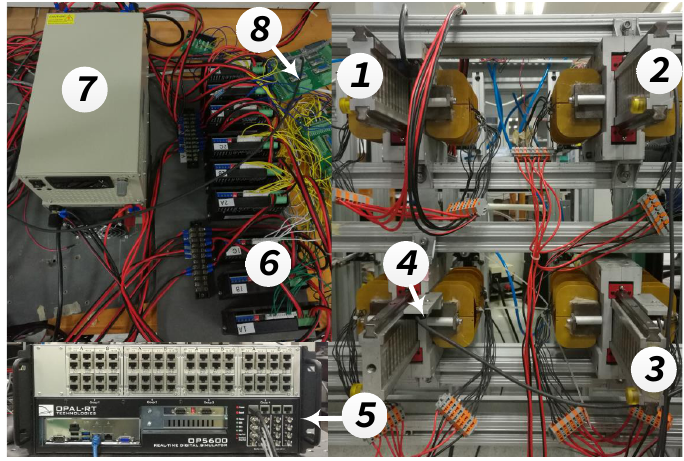
Figure 6. Experimental platform of LSRMs network. (1) LSRM 1; (2) LSRM 2; (3) LSRM 3; (4) linear encoder; (5) RT-LAB; (6) current amplifier; (7) power supply; and (8) connection interface to